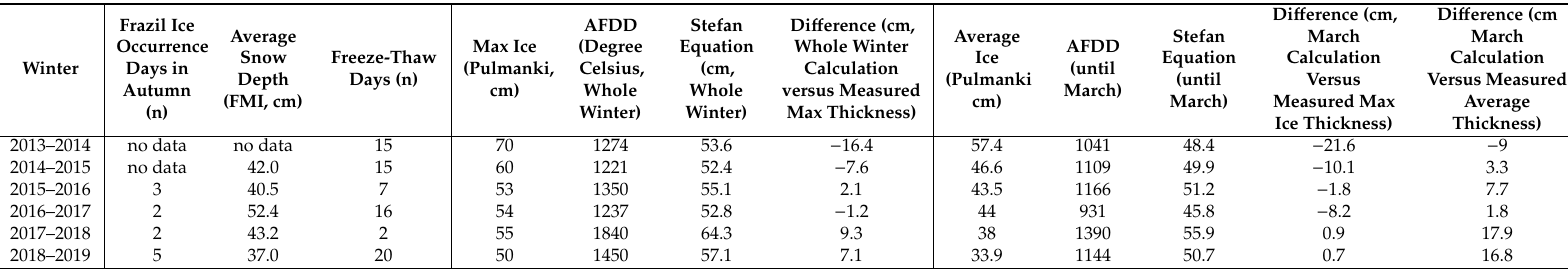
Table 1. The freezing characteristics and ice growth calculations with the selected equations. Average snow depth of FMI’s station is calculated for the three winter months (December–February). The overall average freeze-thaw day number throughout the whole observation period 2013–2019 was 13 days, when rounded.